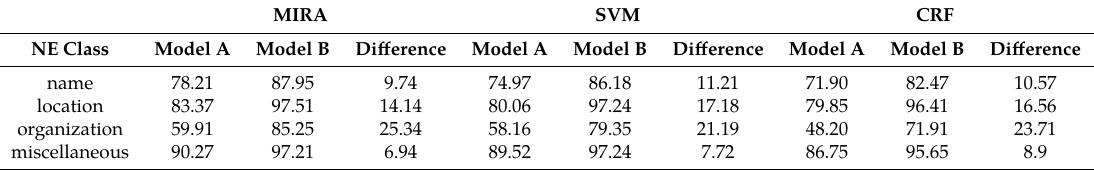
Table 12. Increase in F1-score after including gazetteer features for each class.